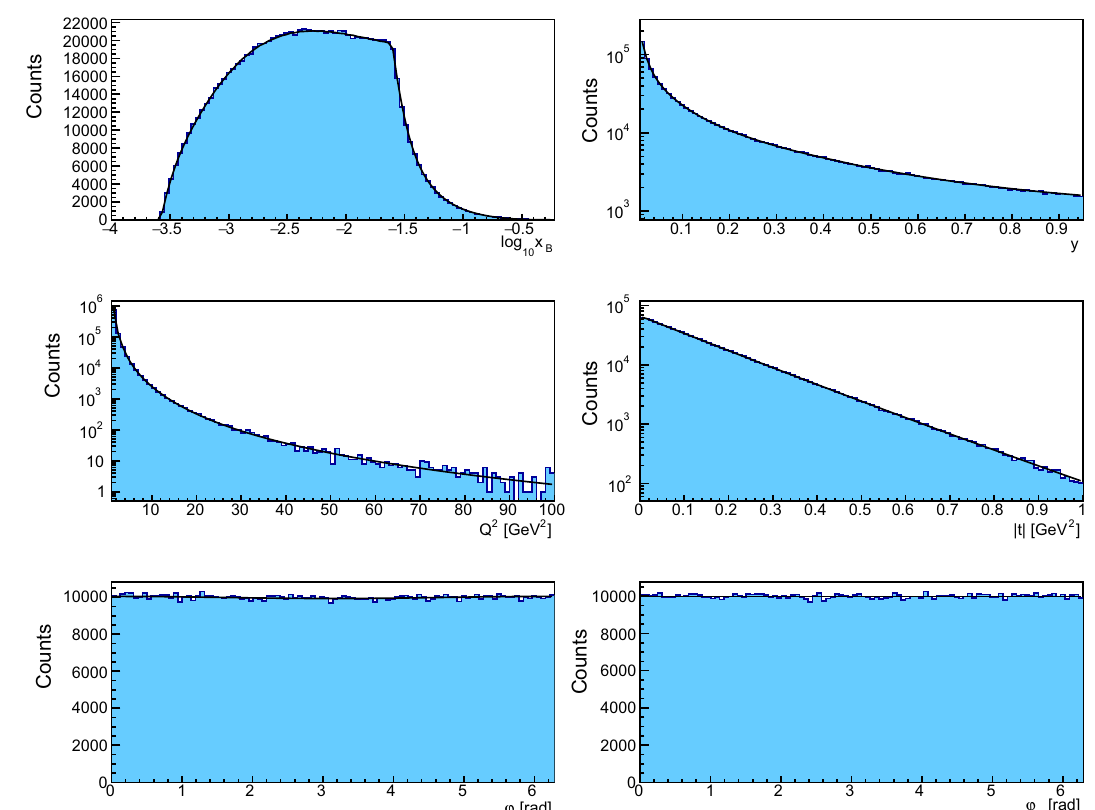
Fig. 4 Distribution of one million DVCS events produced by the DVCSProcessBMJ12 module utilising GPDGK16 GPDs within the PARTONS framework. Events are binned with respect to log 10 ( x B ), y , Q 2 , | t | ,φ and φ S . The solid curves on top of the his-